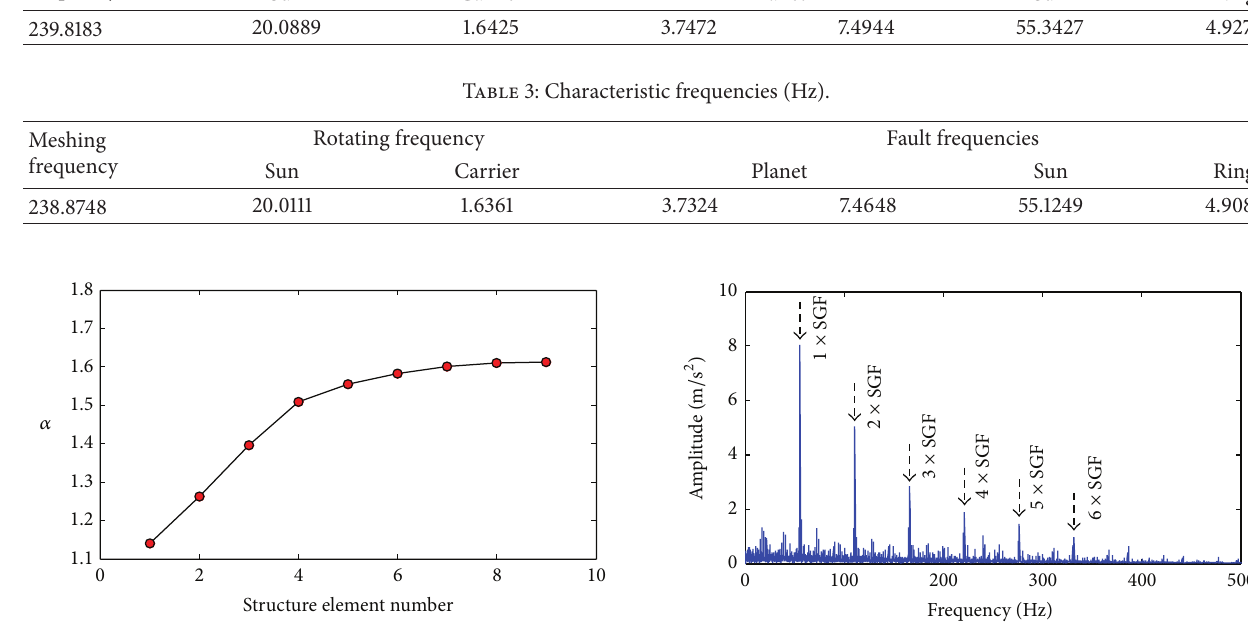
Figure 25: 𝛼 value versus the different SE length.